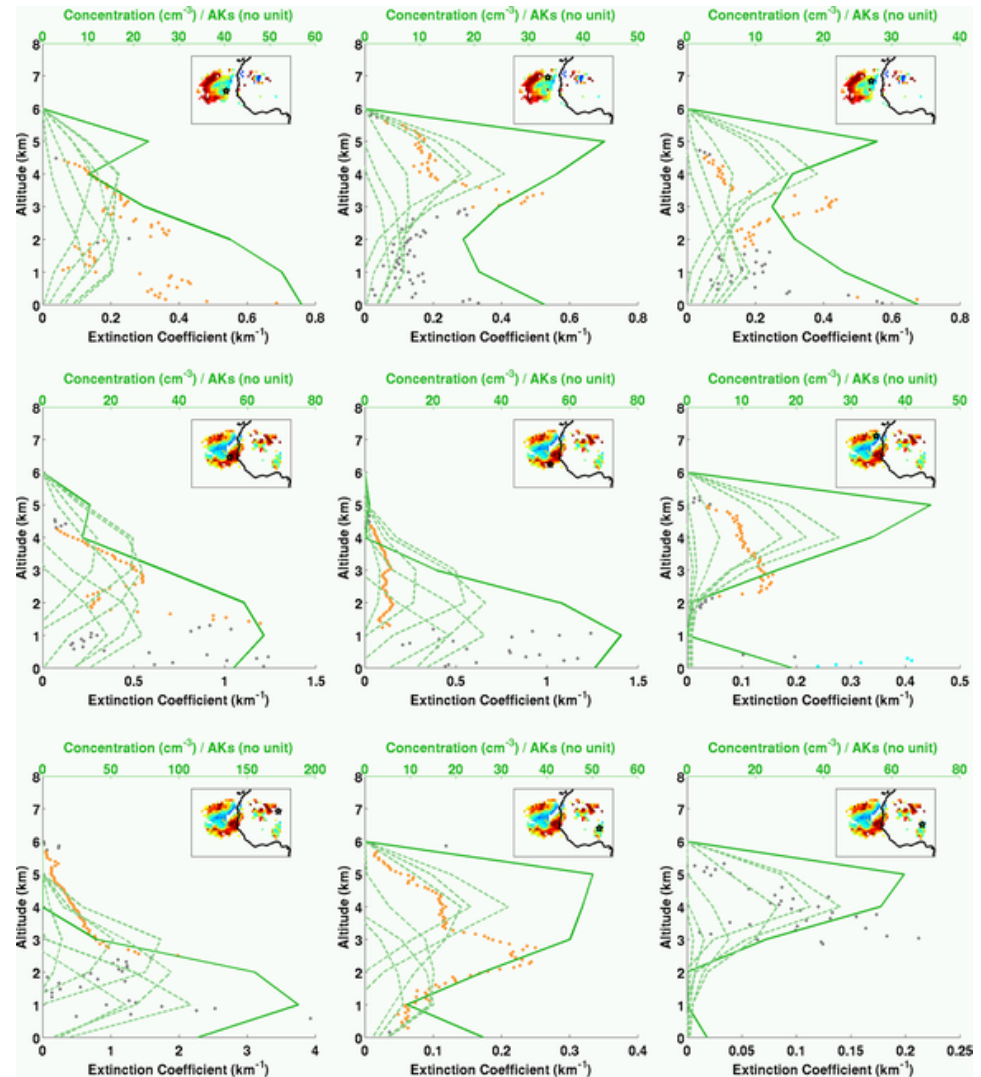
Fig. 10. Example of comparisons between IASI vertical profiles of concentration (green) and CALIOP extinction profiles (average of all measurements within 100km and 6h from the IASI measurement, shown as dots with color depending on the aerosol type reported in CALIOP data). The green dashed lines represent the averaging kernels from the first step of the retrieval (scale not shown, from 0 to 1). On each figure, an insert shows the corresponding OD map, with the location of the specific vertical profile shown as a black